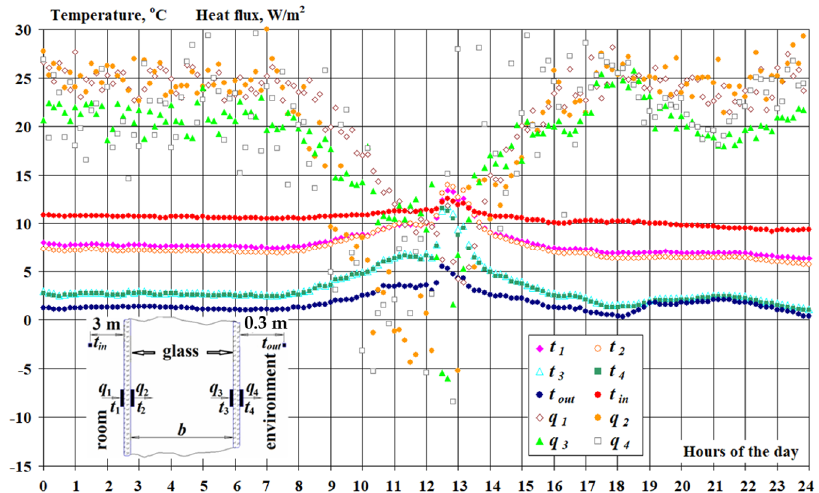
Figure 9. Experimental data for a window 4M 1 -60-4M 1 with a long service life.